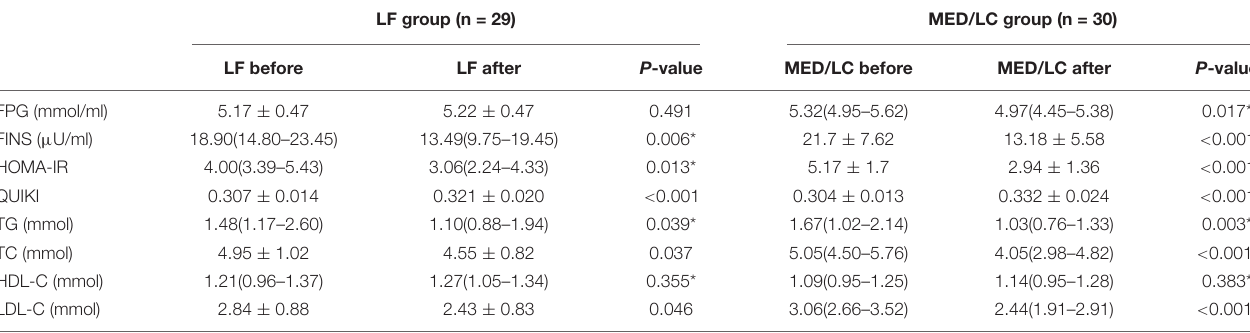
TABLE 5 | Glucolipid metabolism index at baseline and after the